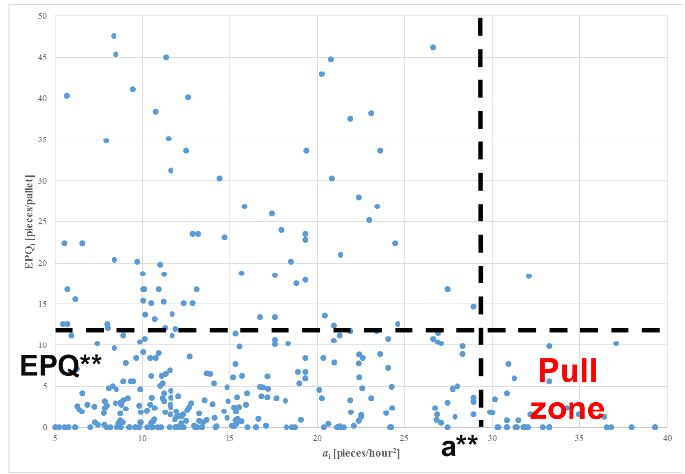
Figure 10. Case study final optimal PUSH/PULL policy definition for different parts.